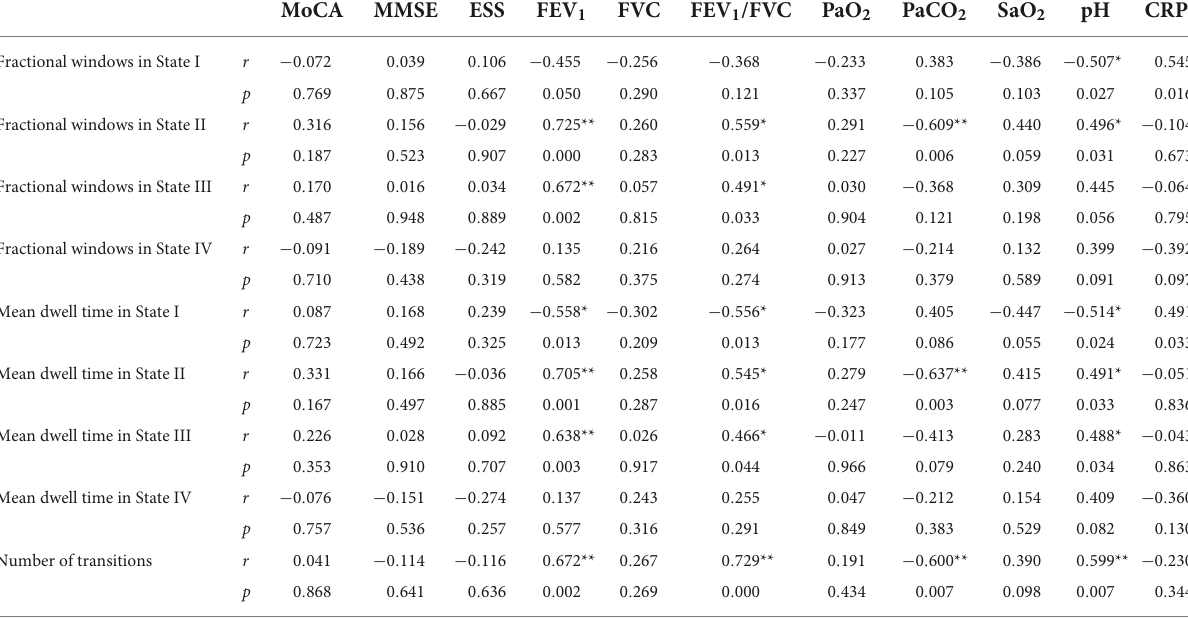
dFNC,dynamicfunctionalnetworkconnectivity;COPD,chronicobstructivepulmonarydisease;HC,healthcontrols;MoCA,MontrealCognitiveAssessment;MMSE,Mini-mentalState Examination; FEV 1 , forced expiratory volume in the first second; FVC, forced vital capacity; PaO 2 , partial pressure of oxygen; PaCO 2 , arterial partial pressure of carbon dioxide; SaO 2 , bloodoxygensaturation;pH,negativelogarithmofhydrogenionconcentrationinastandardvolumeofarterialbloodsample;CRP,c-reactiveprotein. * p < 0.05,** p <